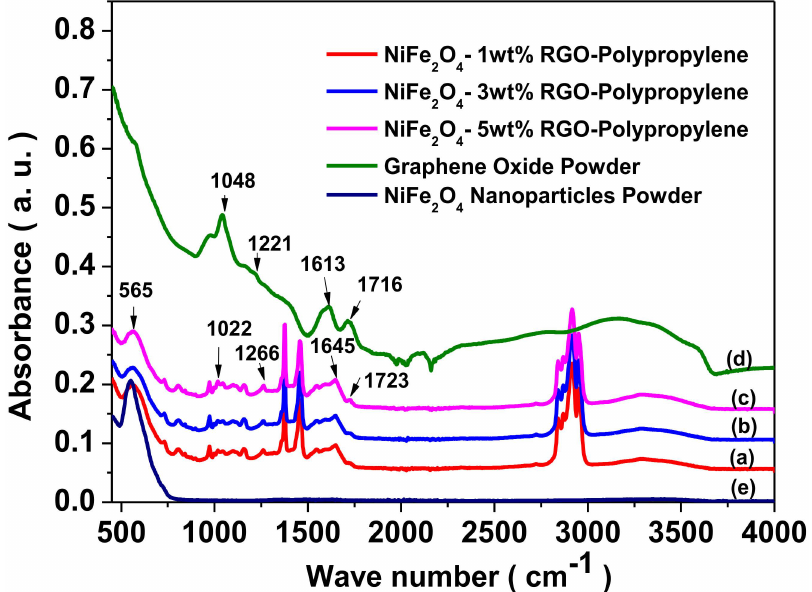
Figure 6. Fourier transform infrared spectroscopy (FTIR) spectra of (a) NiFe 2 O 4 -1wt%RGO-Polypropylene, (b) NiFe 2 O 4 -3wt%RGO-Polypropylene, (c) NiFe 2 O 4 -5wt%RGO-Polypropylene, (d) prepared graphene oxide powder, and (e) NiFe 2 O 4